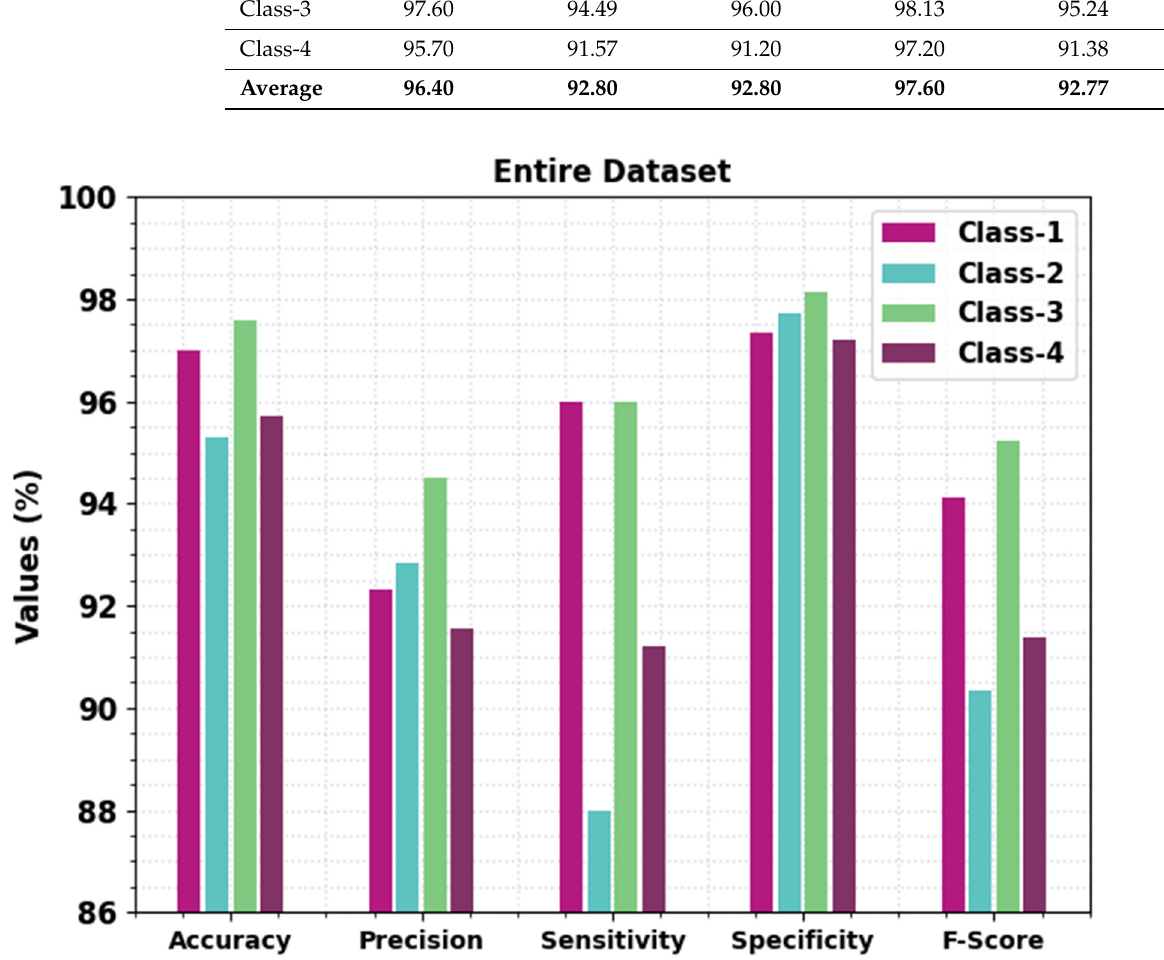
Figure 4. Crowd classification outcome of the AOTL-CDA3S system under the entire database.